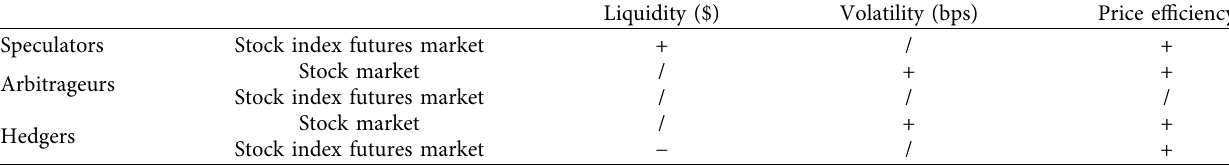
Table 17: Impact of different types of investors on the quality of the futures and cash